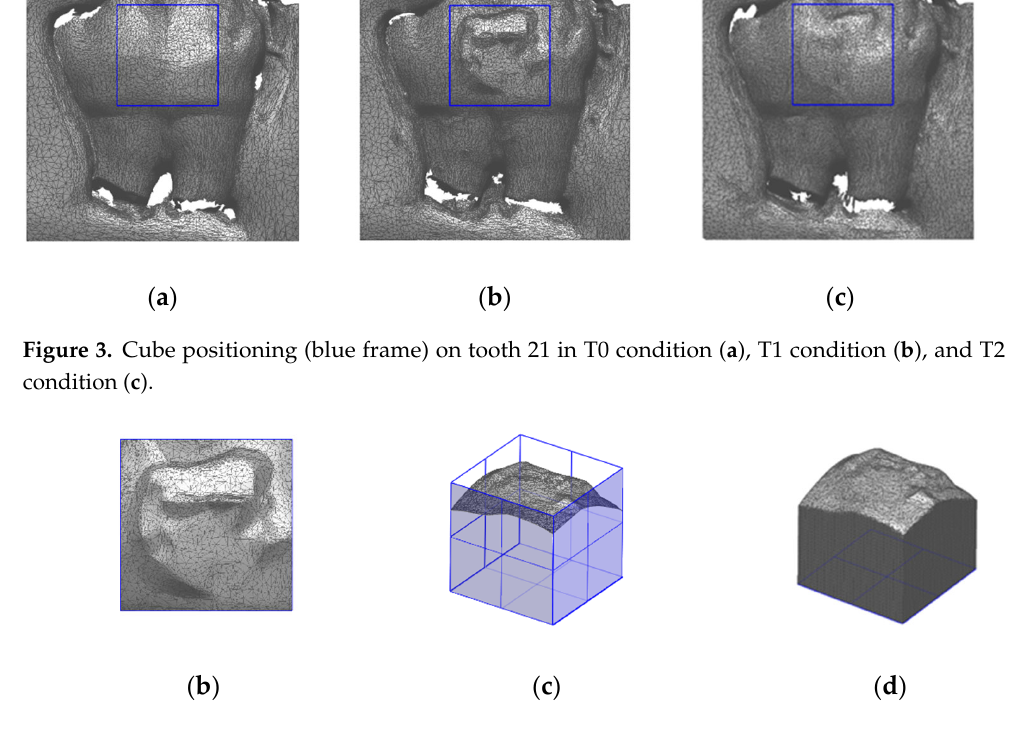
Figure 4. Cube positioning (blue frame) in T1 condition on tooth 21 ( a ); cut surface of T1 condition in top view ( b ); cut surface in iso view with cube planes ( c ); closed shell ( d ) .